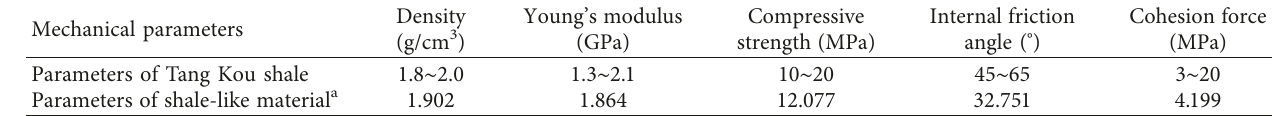
Table 1: Comparison table of parameters between shale-like material and Tang Kou shale.